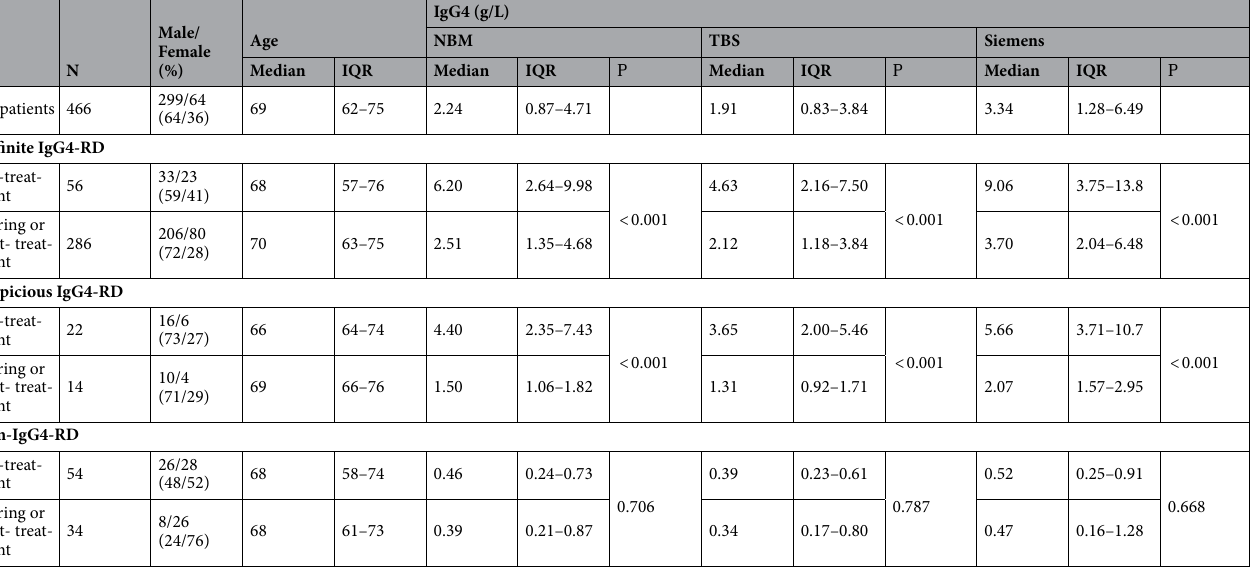
Table 1. Characteristics of patients and median serum IgG4 levels with each reagent. IQR interquartile